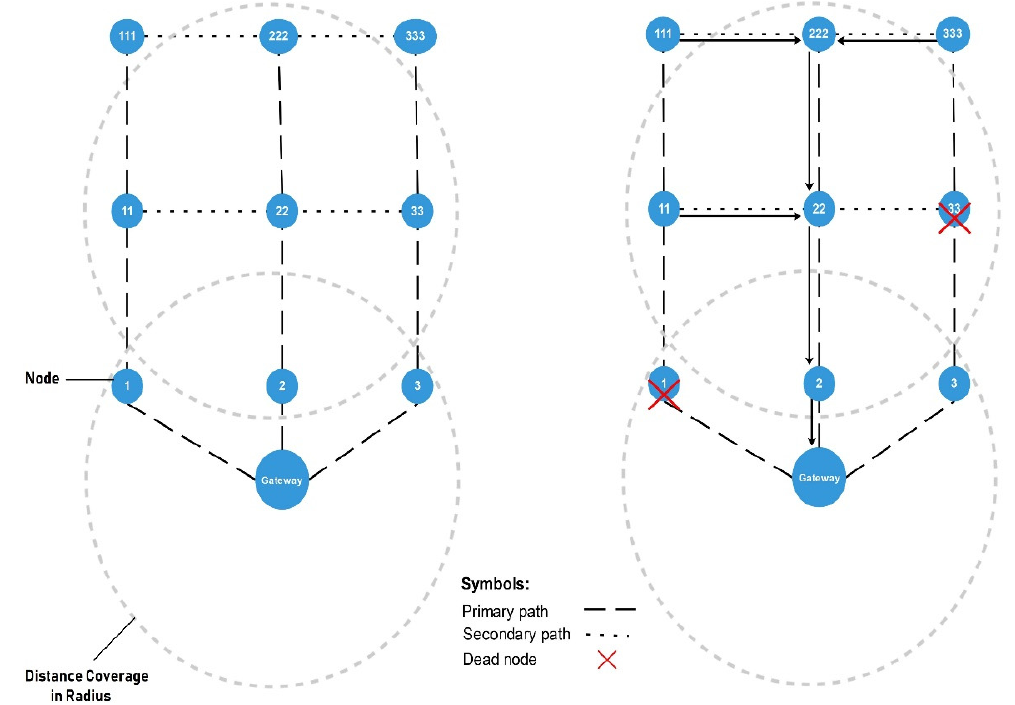
Figure 9. Retransmission diagram for offline nodes